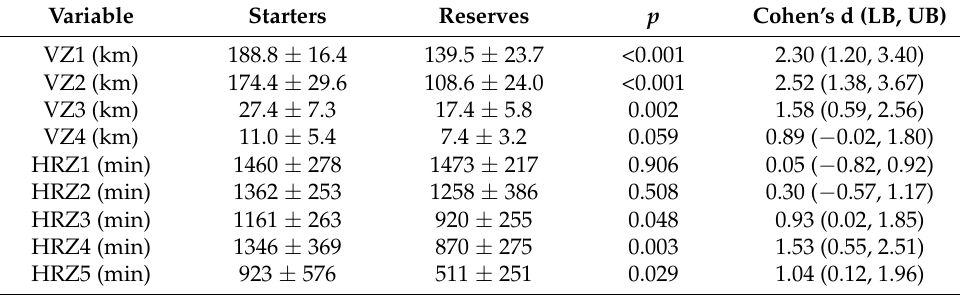
Figure 2. Differences in accumulated training load ( A ) and number of sprints ( B ) between starters and reserves in match settings, practice settings, and the cumulative total season. * p < 0.001. Table 1. Total accumulated workloads for all sessions in NCAA Division III women’s soccer by starting status (mean ±